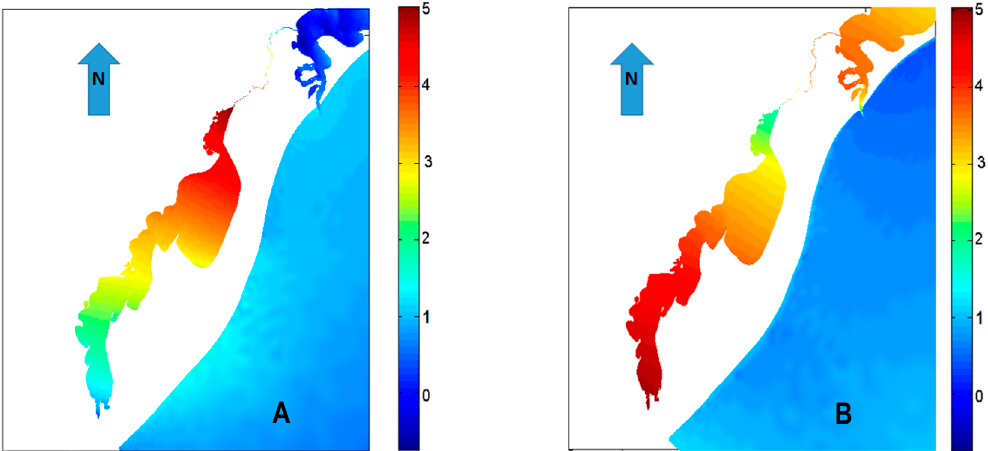
A B Figure 6. Water levels calculated by the model for the maximum ( A ) southwest wind and ( B ) northwest wind from the simulated period.